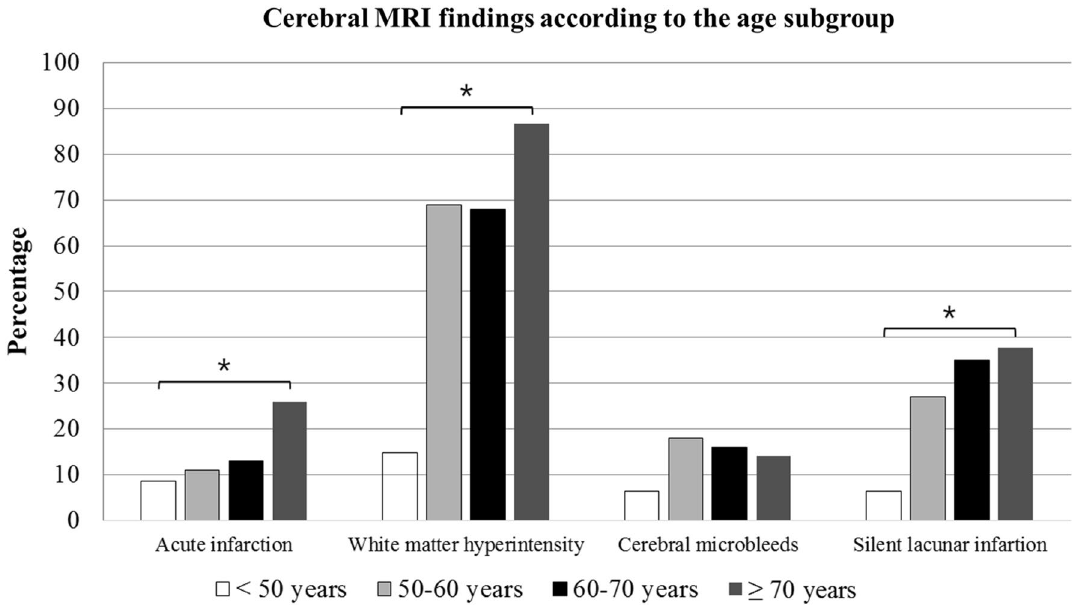
Figure 2. Graphs showing prevalence (%) of cerebral co-incident acute infarction and small vessel disease including white matter hyperintensity lesion, cerebral microbleeds, and silent lacunar infarction by age at the time of cerebral magnetic resonance imaging. The prevalence of cerebral MRI lesions tends to increase with age except cerebral microbleeds. MRI = magnetic resonance imaging. *Significant difference, P < 0.05, χ 2 test.